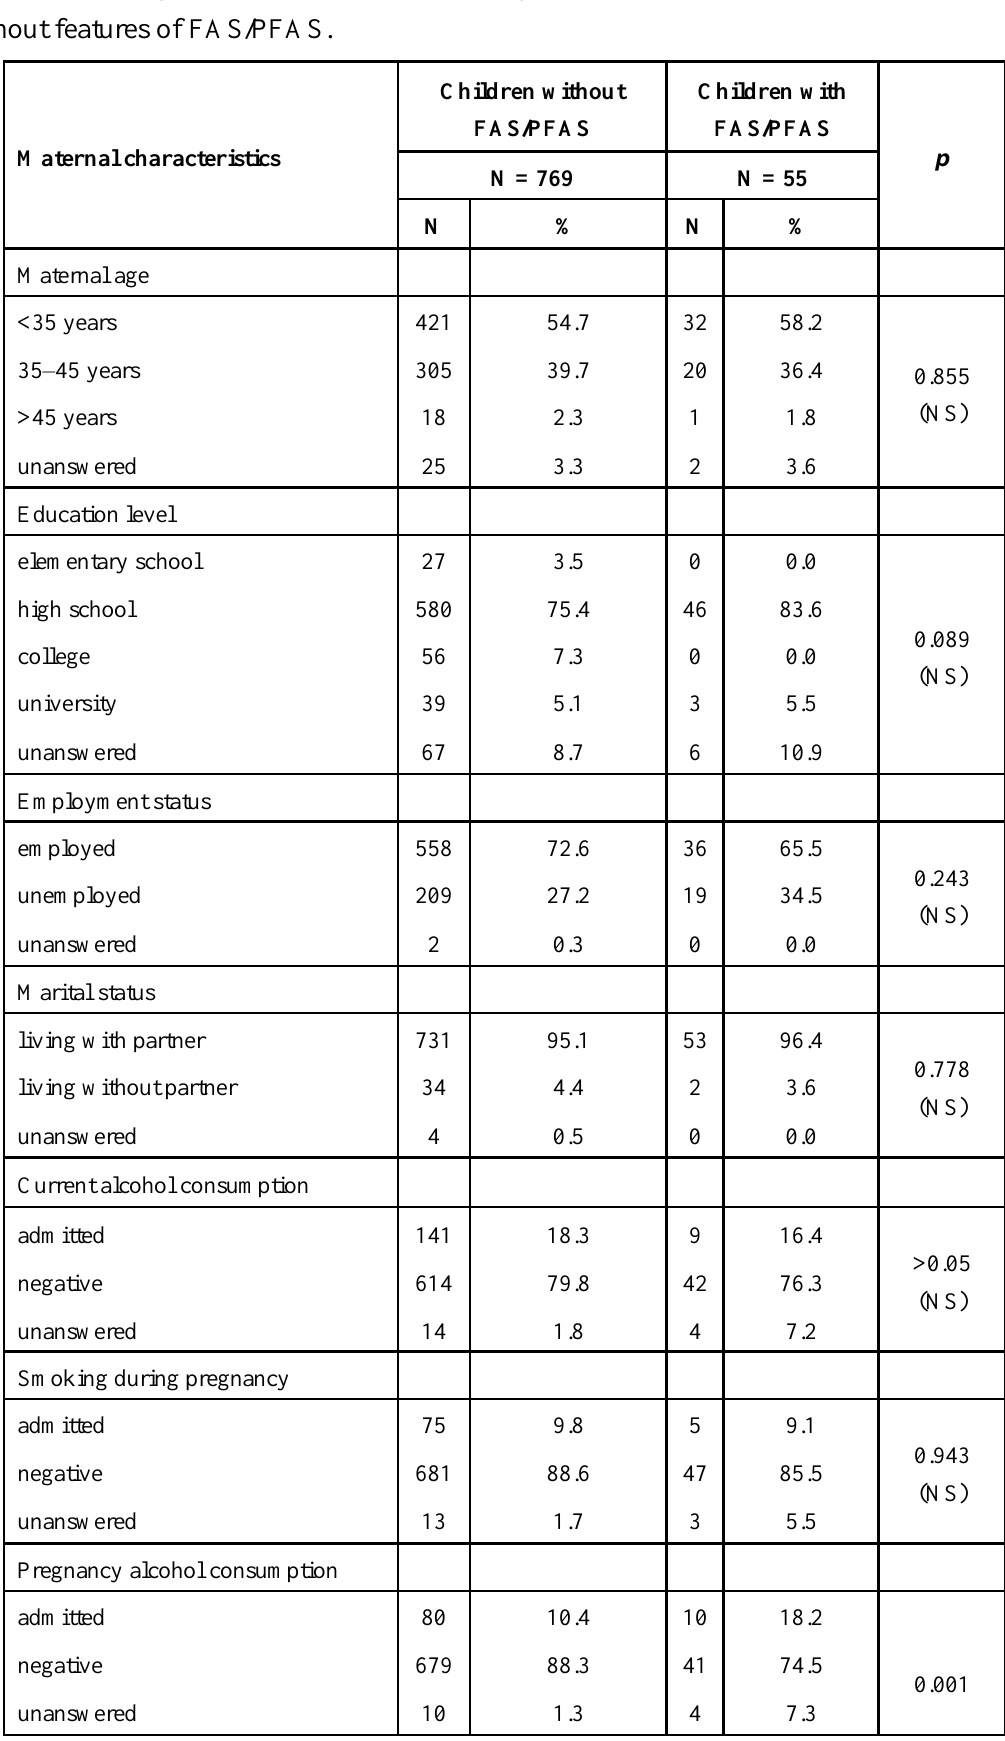
Table 3. Demographic and substance use by mothers of examined children with and without features of